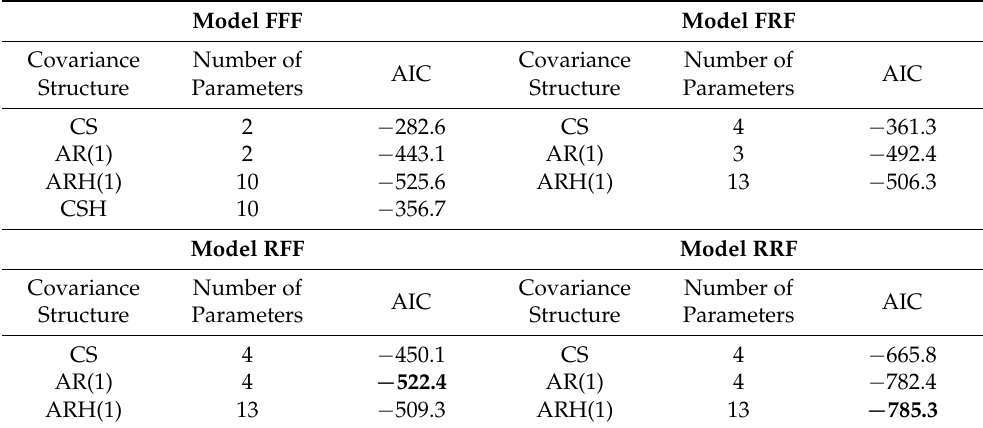
Table 4. Akaike’s Information Criteria (AIC) for the covariance structures in partitioned models.